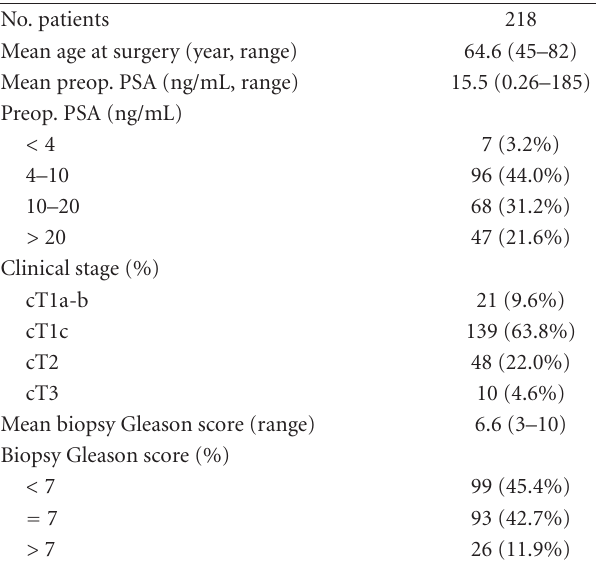
Table 1: Clinical patient and pathological